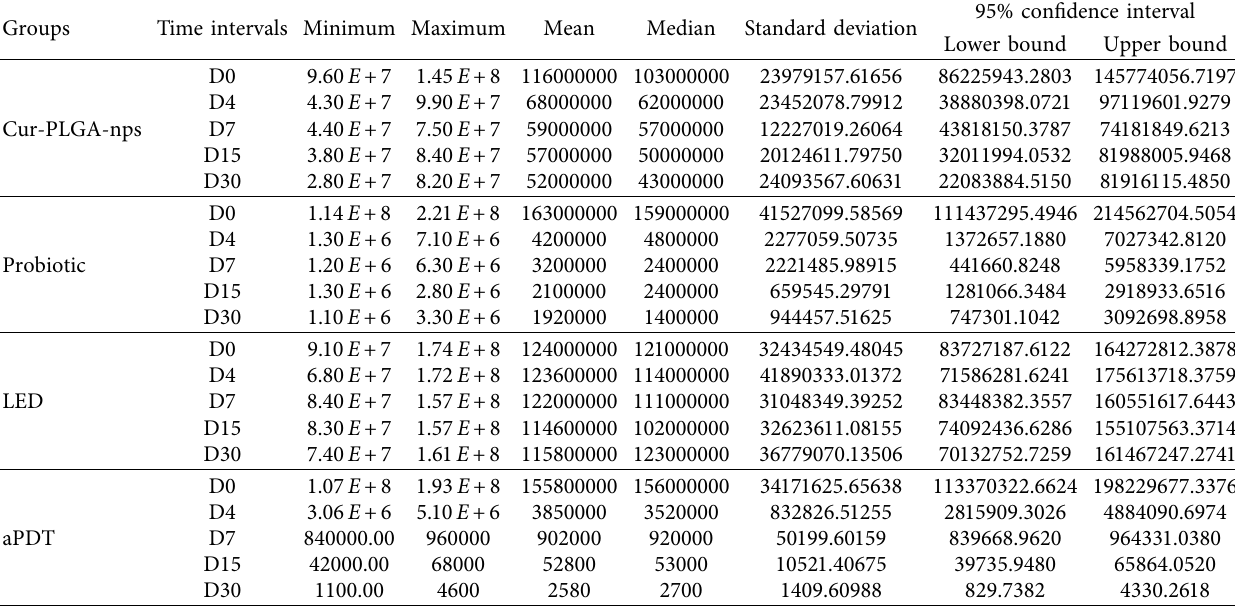
Table 1: The minimum, maximum, mean, median, standard deviation, and 95% confidence interval of S. mutans CFU/mL following each treatment in different time intervals.